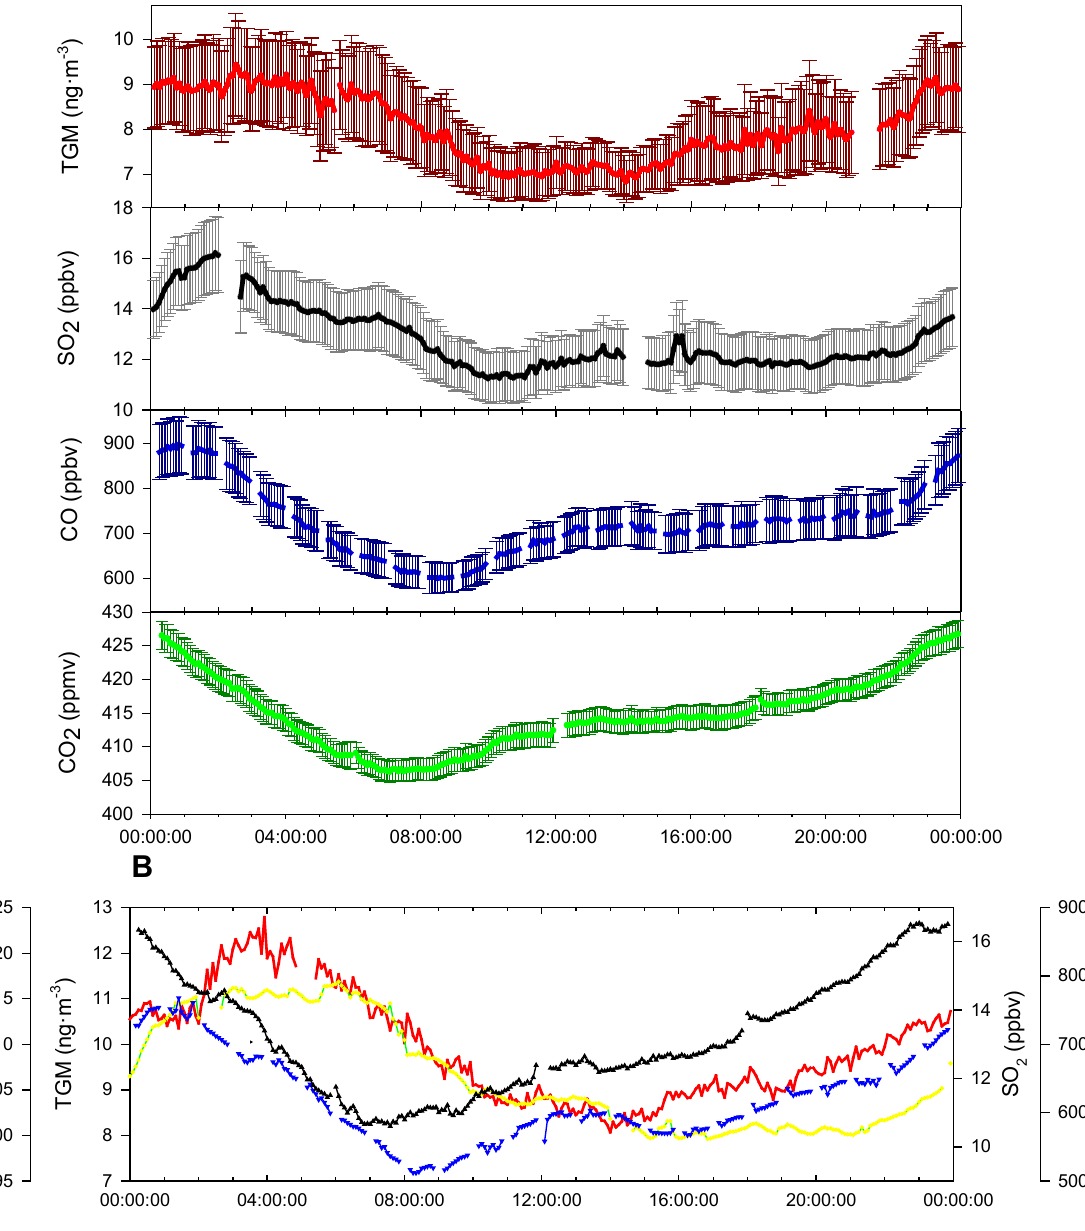
Figure 8. ( A ) Nine-month average diurnal cycle of the sampling period of TGM (Red), SO (Black), CO (Blue), and CO (Green), with error bars representing 95% confidence 2 2 interval. ( B ) Average diurnal cycle for summer season (June–August). The time axis is in UT, i.e. , local time − eight